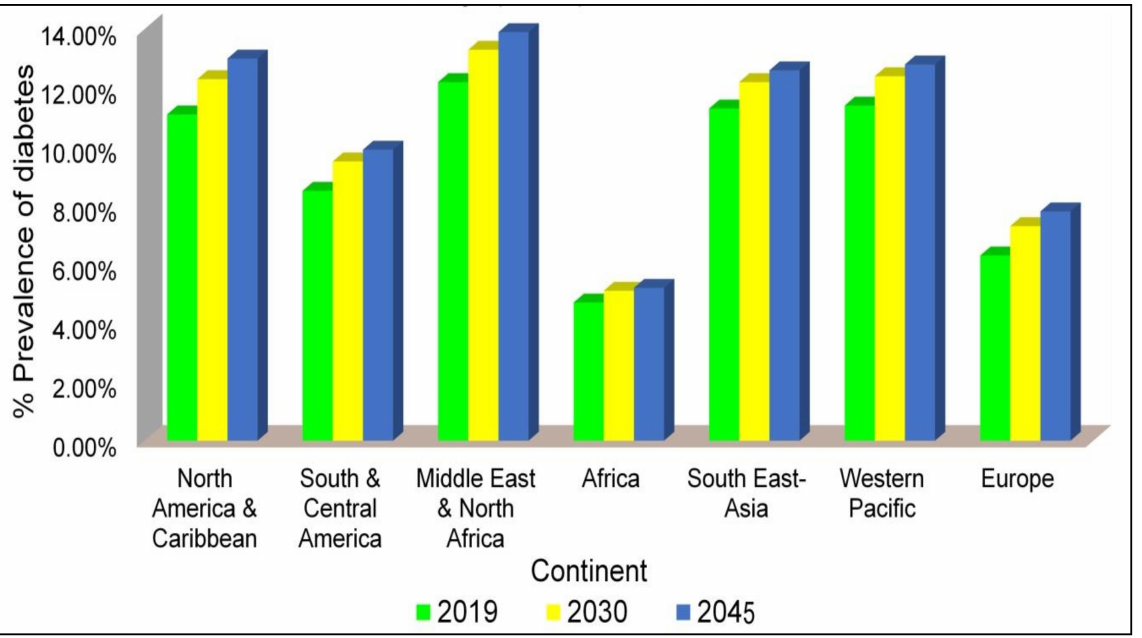
Figure 2. Predicted prevalence of diabetic patients in the year 2019, 2030, and 2045 in different